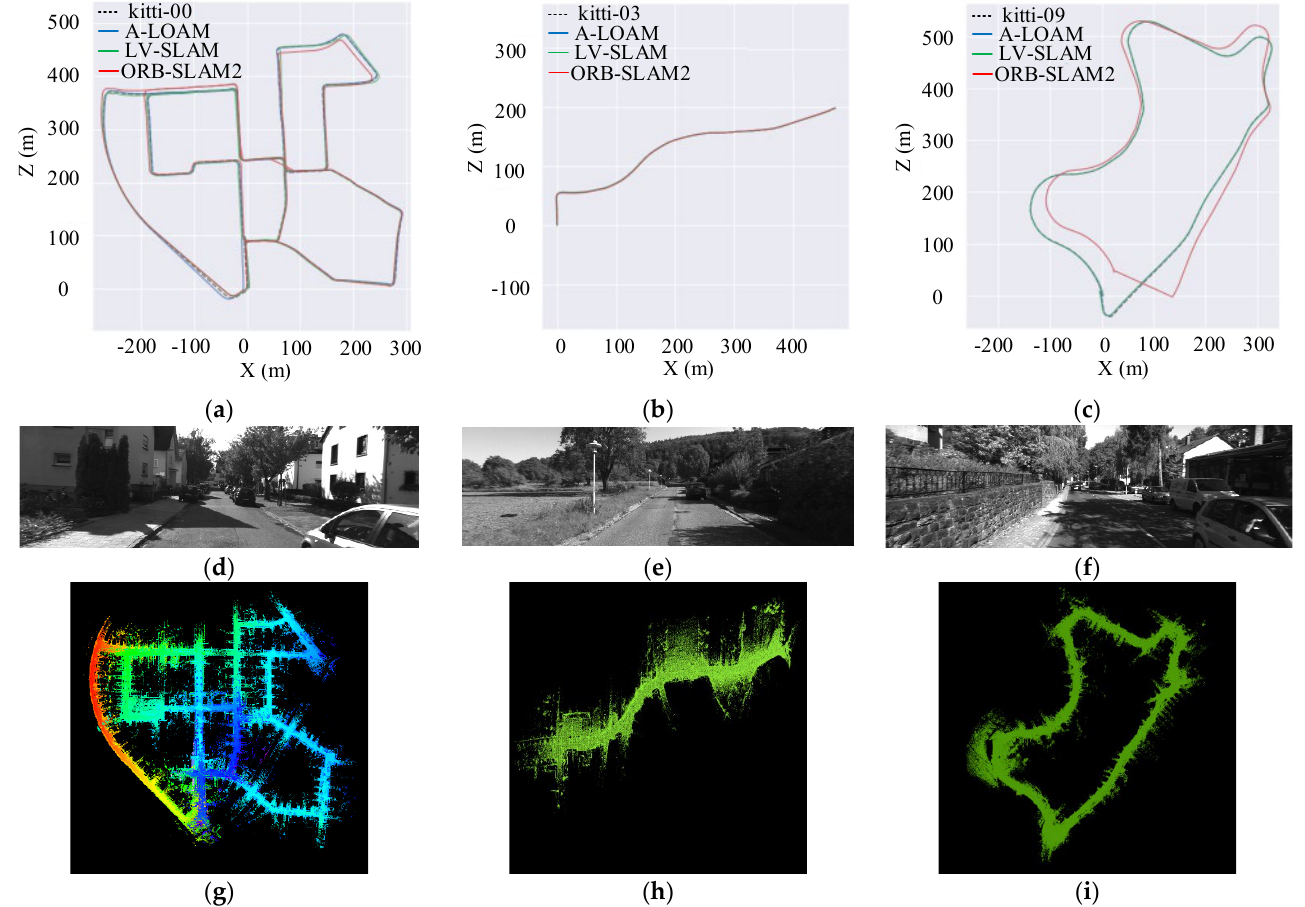
Figure 7. Comparison graph of each algorithm’s output trajectory. The datasets are chosen from three types of environments: urban, country, and suburb from left to right. In ( a – c ), we compare the results of the different algorithms to the GPS/INS ground truth. An image is shown from each dataset to illustrate the three environments in ( d – f ) and the corresponding point cloud map output by the LV-SLAM algorithm in ( g – i ).